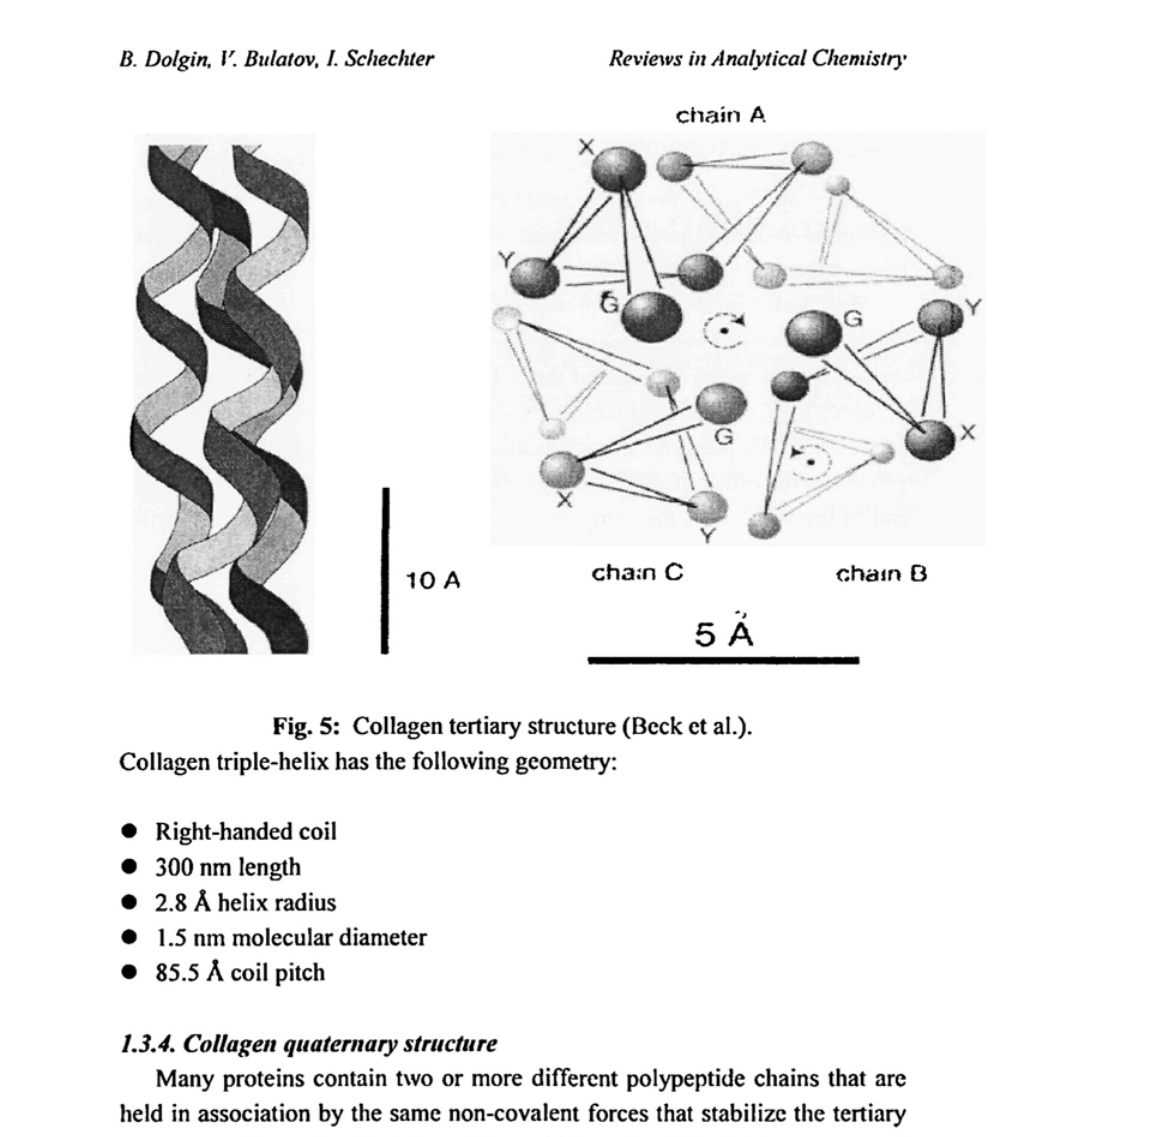
Fig. 5: Collagen tertiary structure (Beck et